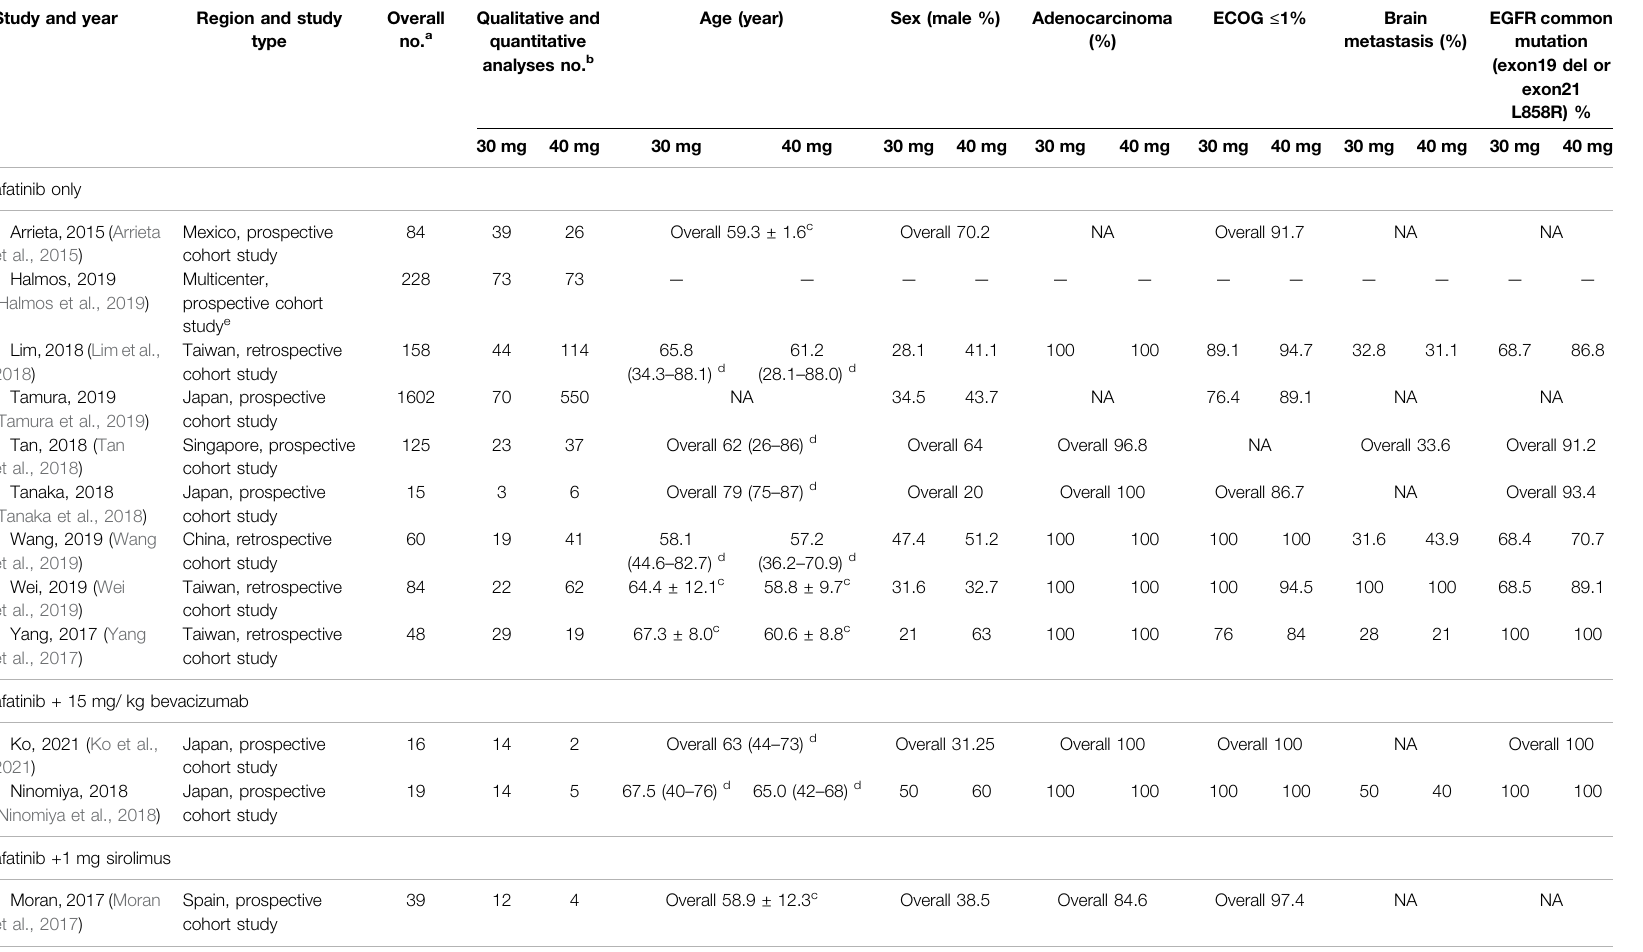
TABLE 1 | Characteristics of the included